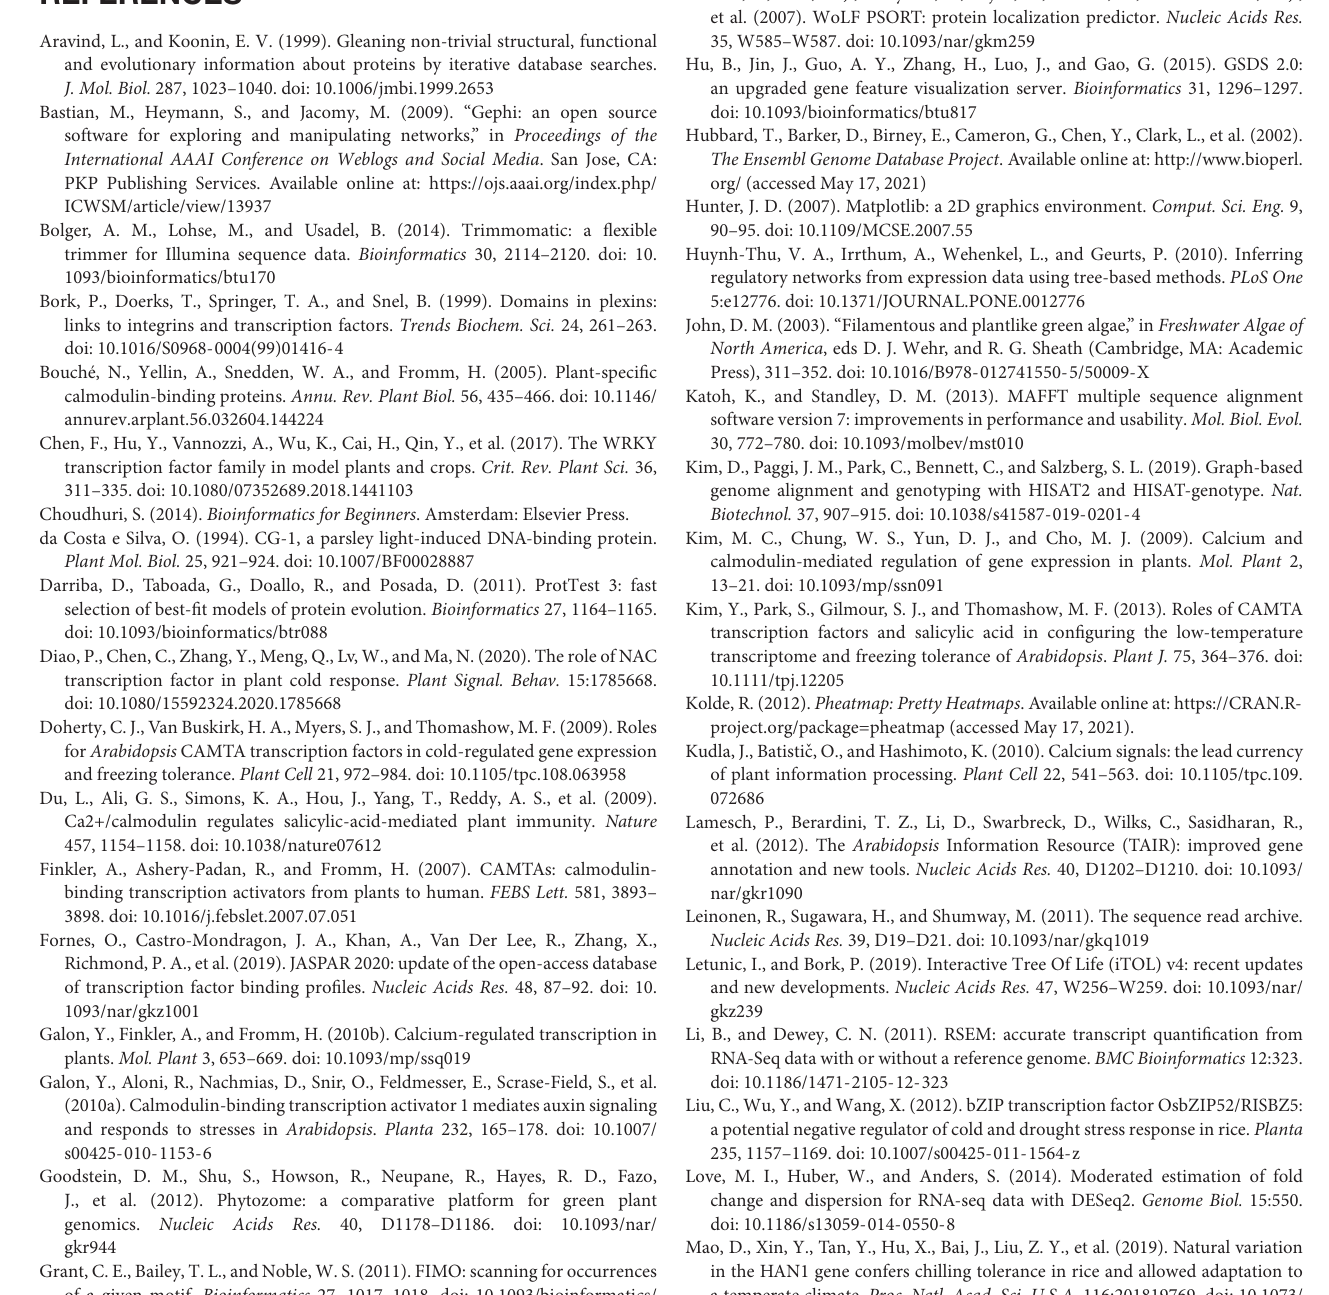
Supplementary Table 4 | Intron number and intron phase of identified CAMTA genes. Supplementary Table 5 | The selected representative species. Supplementary Table 6 | Length, molecular weight, and isoelectric point of identified CAMTA proteins. Supplementary Table 7 | Gene Ontology analysis of identified CAMTA